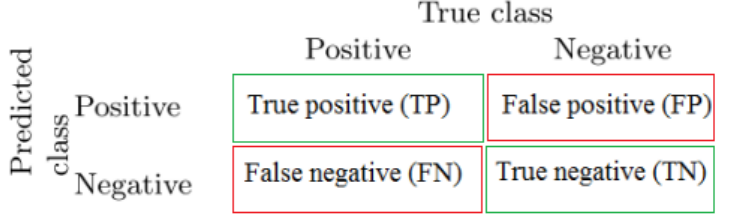
Figure 11. Performance indices used in fault